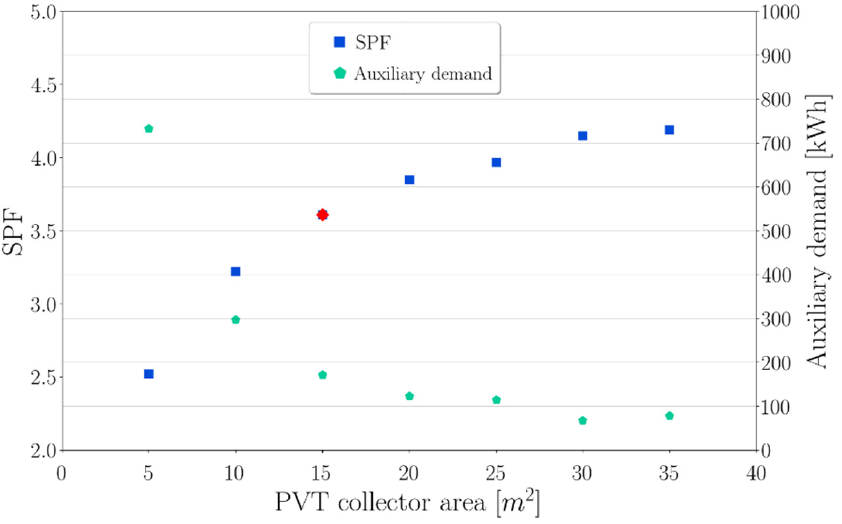
Figure 27. SPF and the auxiliary energy demand for different collector areas (Dimark Solar). The SPF